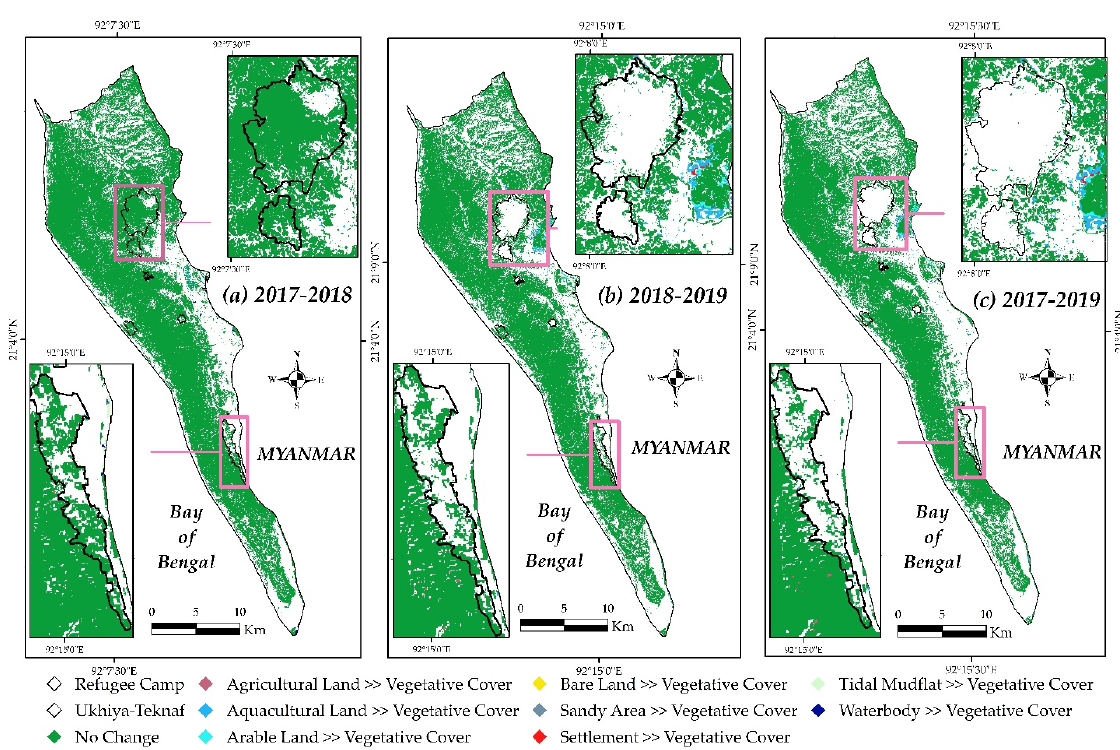
Figure 14. Conversion of vegetative cover from other land use/land cover, Ukhiya-Teknaf. ( a ) 2017–2018, ( b ) 2018–2019, and ( c ) 2017–2019.